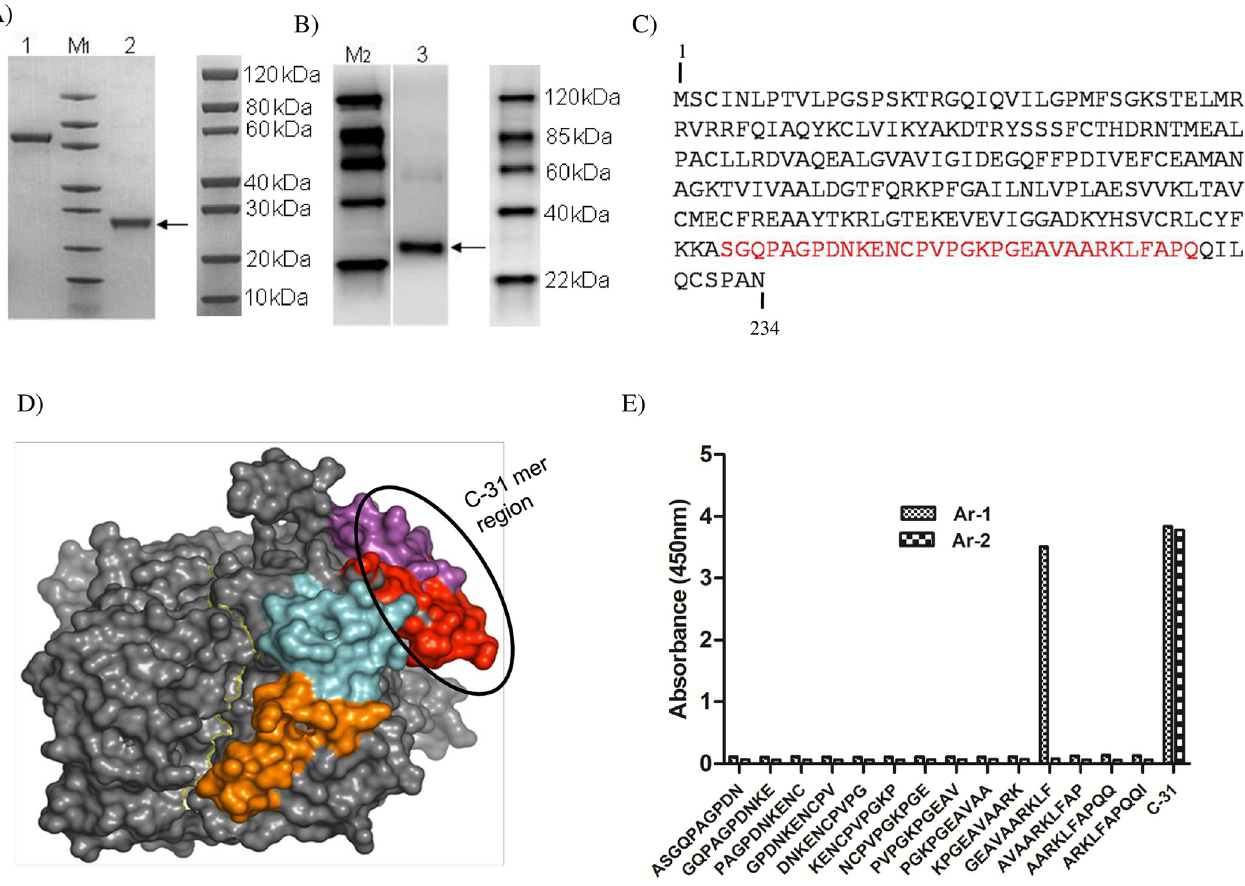
Fig 1. Characterization of TK1 antibodies. (A) An SDS-PAGE was performed with a 4% - 20% gradient gel for analysis of purified recombinant TK1, followed by Coomassie Blue staining, Lane 1: BSA (2.00 μ g), Lane 2: Thymidine Kinase 1 (2.00 μ g). (B) Western blot analysis of His-tag purified recombinant TK1 using Anti-His antibody (0.2 μ g/mL), Lane 3: Thymidine Kinase 1 (C). The amino acid sequence of the human TK1 cDNA. The red color indicates the peptide sequences used for TK1 antibody production. (D) A model of the full-length human TK1 tetramer (produced by Martin Welin et al ref 14). The exposed KEN sequence and the C-terminal are shown in red and purple, and the lasso loop/active site is shown in light blue. (E) Pepscan analysis of the binding site of the anti-TK1 monoclonal antibodies with peptides from the 193–226 regions of TK1.